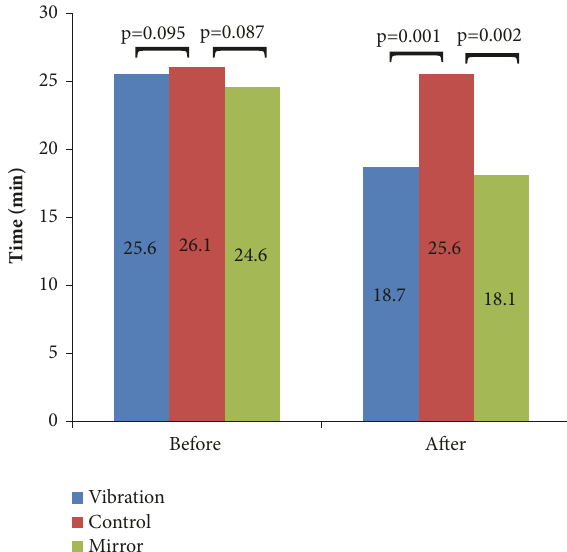
Figure 2: Data of the Jebsen Taylor Test among the individuals of the control group, vibration and mirror therapy before and after the interventions.